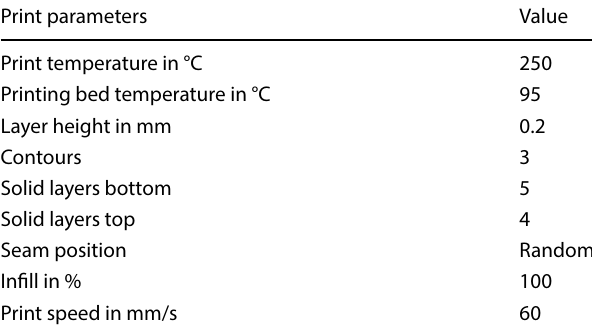
Table 5 Used print parameters for all printed tensile specimens